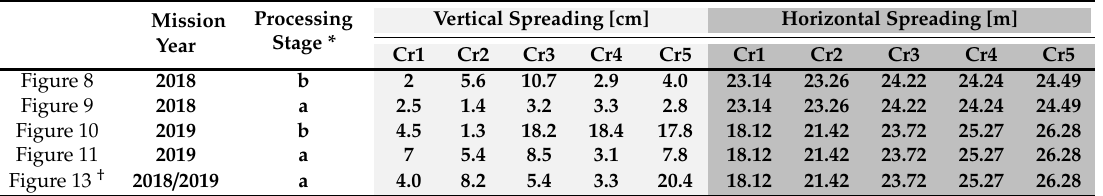
Table 4. Relevant to Equation (3), to the 5 CRs and the 5 acquisitions considered in the Figures 8–11, 13:.standard deviation of the quantities ∆ R (vertical spreading) and R (horizontal spreading).